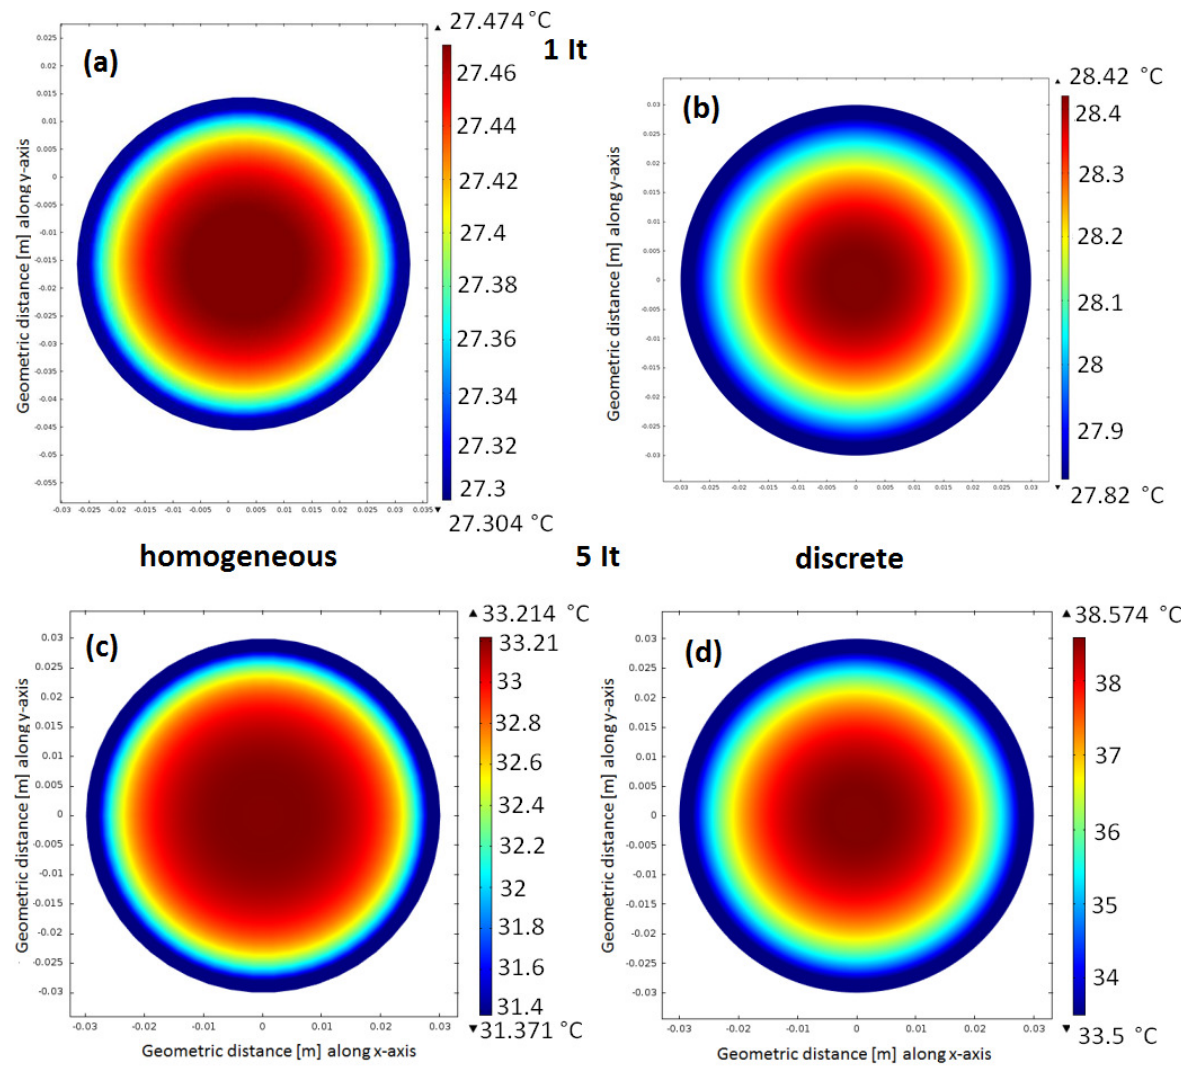
Figure 13. Internal temperature distributions during a 1 I ( a , c ) an homogeneous and ( b , d ) a discrete internal